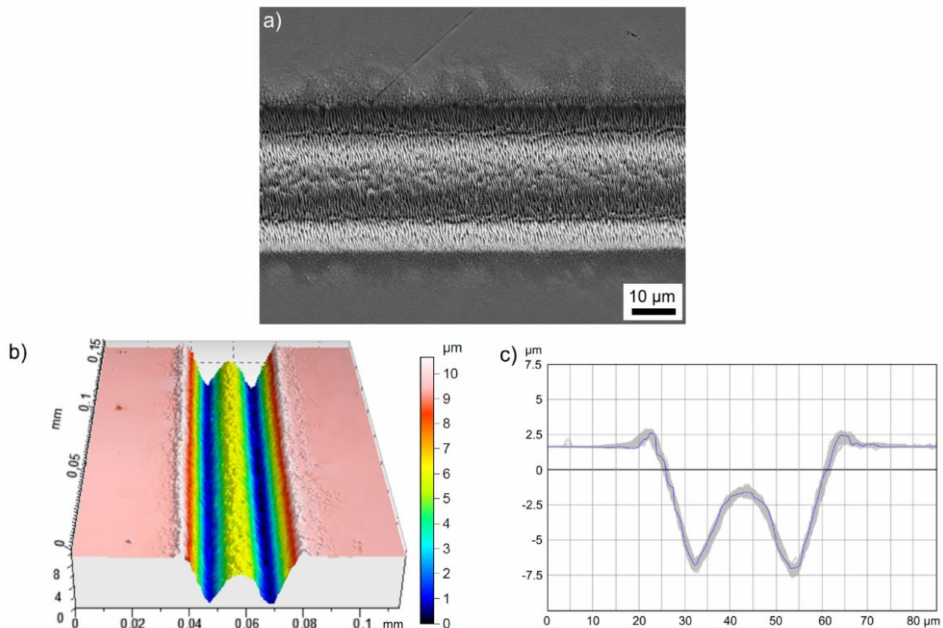
Figure 9. Micro-channel fabricated on stainless-steel using the squared donut-like intensity distri- bution at z = − 0.9 mm, 10 over-scans with v = 0.1 m/s and a single-pulse energy of 4.6 µ J: ( a ) SEM micrograph, ( b ) WLIM micrograph and ( c ) cross-sectional height profile. The blue line in ( c ) corre- sponds to the mean profile and the grey shadow illustrates the profile series measured along the channel in ( b